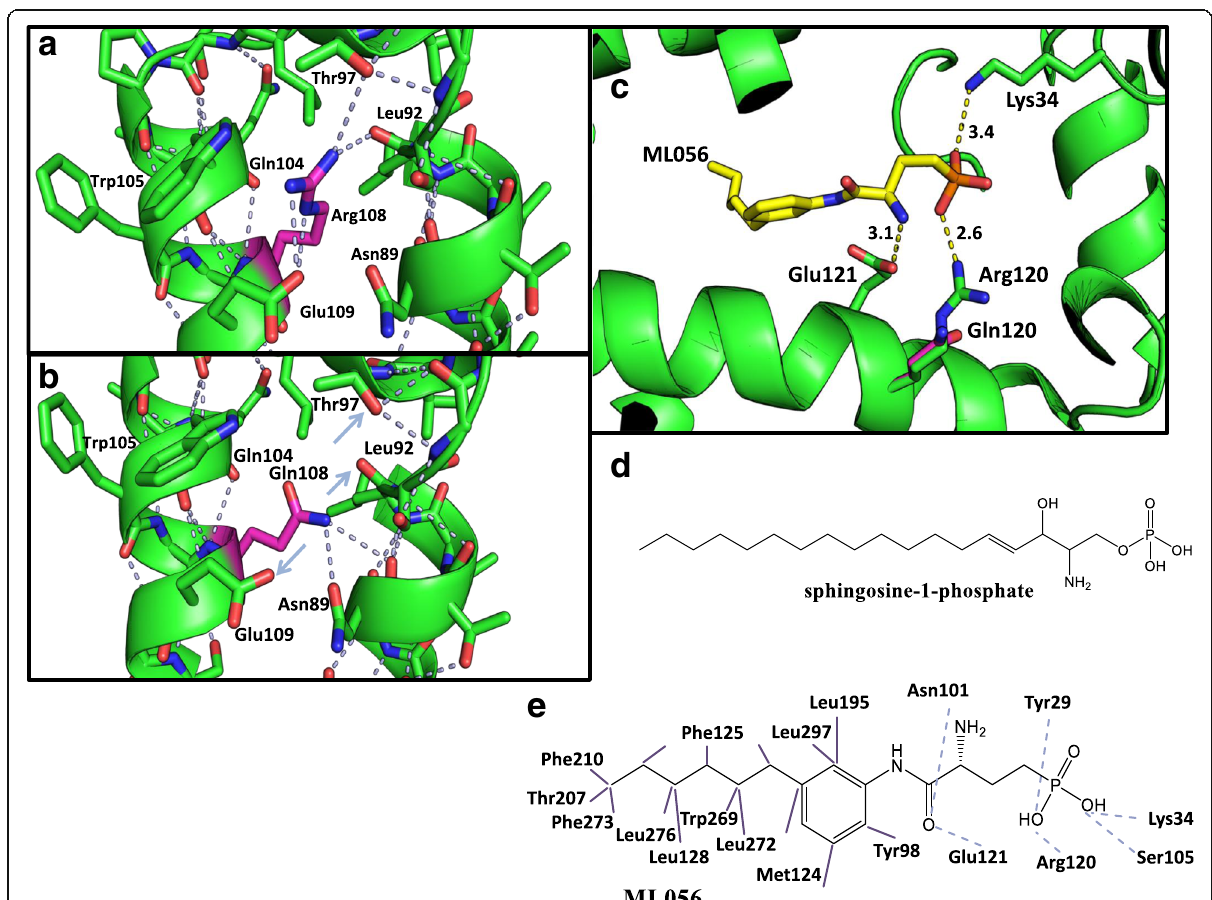
Fig. 4 3D and H-bond analysis of S1PR2 amino acid residue exchanges at position 108. H-bonds are predicted by the modeling program PyMol. The amino acid in position 108 is marked in magenta. H-bonds are marked in grey dashes. The interacting amino acids are labeled. a WT arginine and b mutant glutamine at position 108. Small grey arrows present missing H-bonds. c Crystal structure of S1PR1 (3v2y). The p.Arg120Gln substitution (magenta) is described in relation to the ligand ML056. The amino acids p.121Glu and p.120Arg build ionic and H-bonds (yellow dashes) with the ligand ML056 (yellow structure). The Å-distances are listed at the yellow dashes. d Chemical structure of the sphingosine-1-phosphate. e The chemical structure of the S1P analog, ML056. The dashed grey lines show the polar interactions between amino acids of S1PR1 and the ligand and the purple lines represent the hydrophobic interactions of ML056 with the amino acids of S1PR1